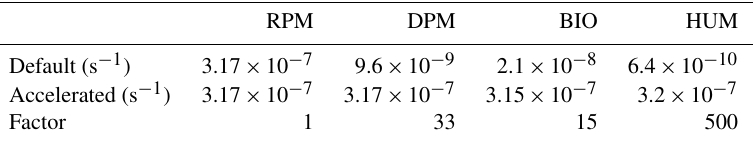
Table 3. Turnover rates for the four soil carbon pools (RPM is the resistant plant material, DPM is the decomposable plant material, BIO is the microbial biomass, and HUM is humus). The factor is used to rescale soil carbon pools between the modified AD and default composition